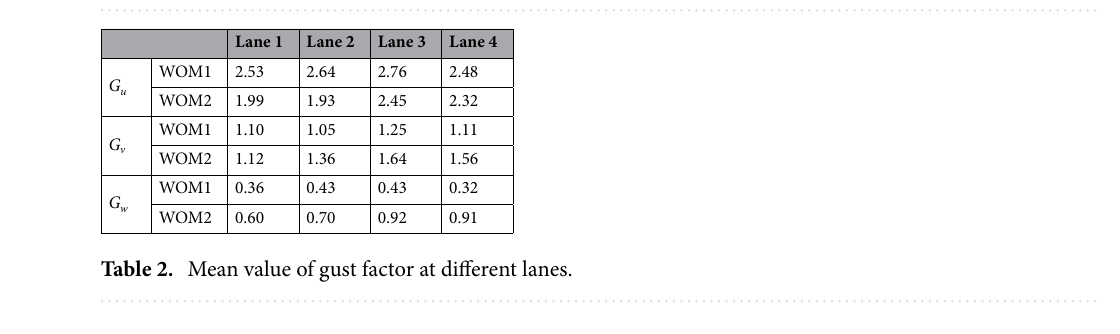
Figure 6. The Relationship between gust factor and wind speed at: (1) Lane 1, (2) Lane 2, (3) Lane 3, (4) Lane 4.